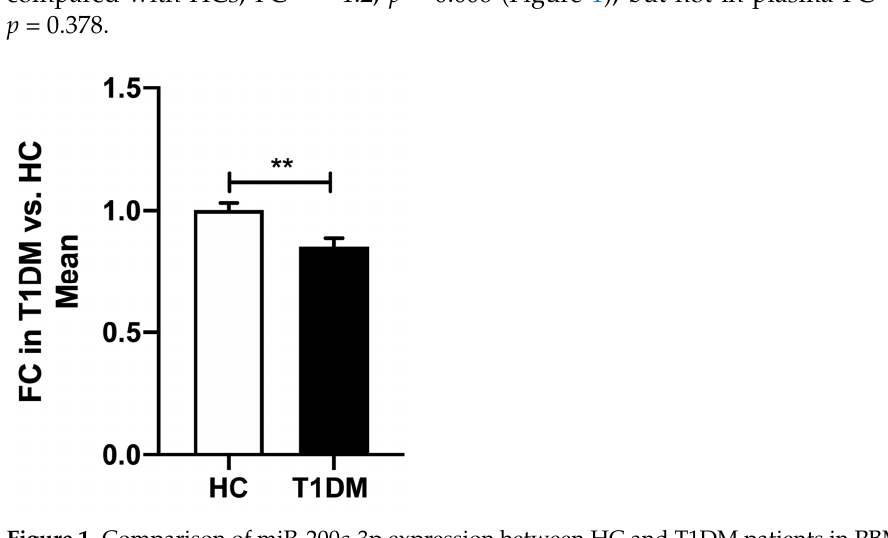
Figure 1. Comparison of miR-200c-3p expression between HC and T1DM patients in PBMCs. Data are represented as mean ± SEM and analyzed by unpaired t -tests. ** p < 0.01.